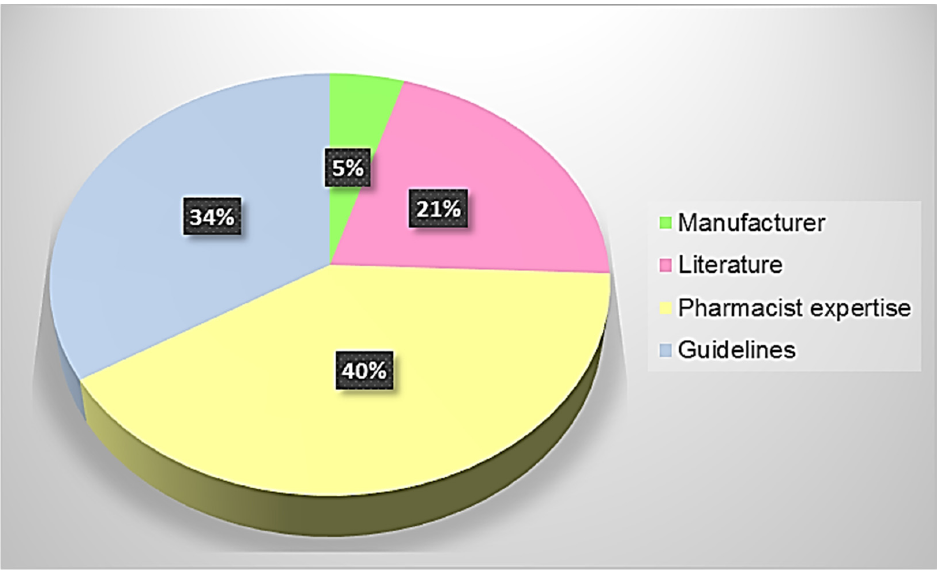
Figure 5. The weight of pharmacist skill in the administration of a therapy by feeder tube. The different colors are indicative of the sources behind the decisions on the feasibility of using a solid pharmaceutical form administered by tube.